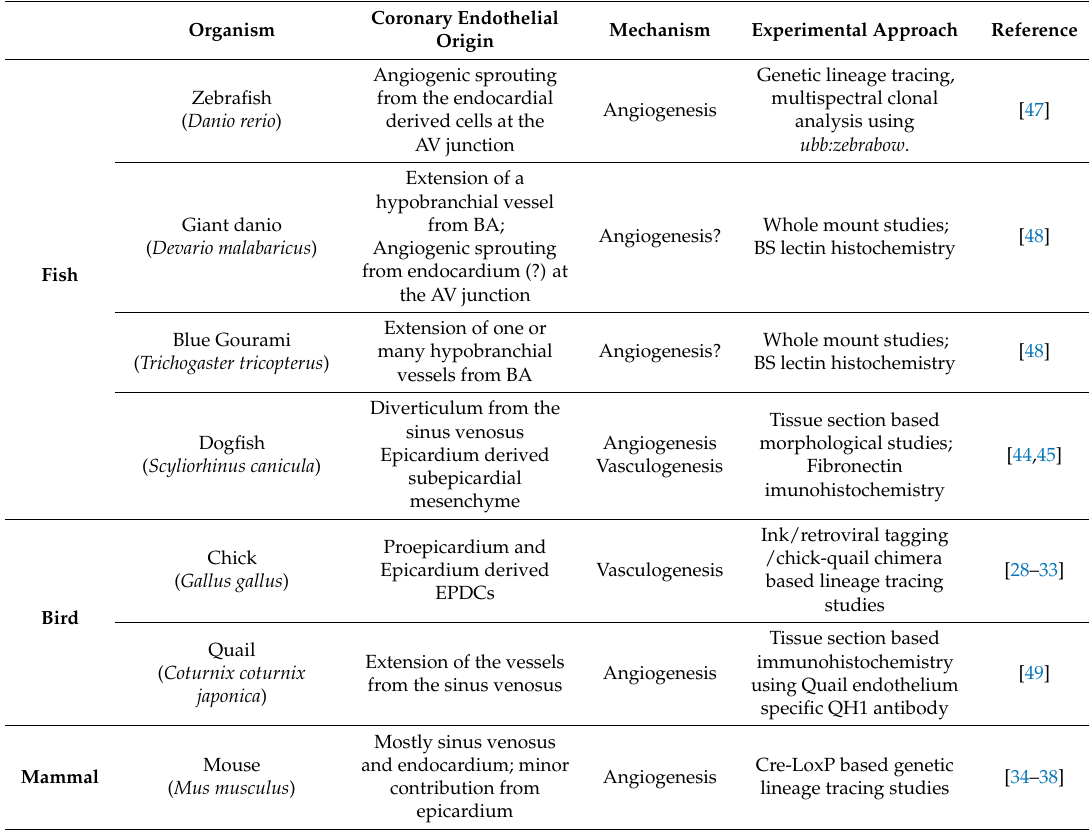
Table 1. Origins of coronary endothelial cells in fish, avian and